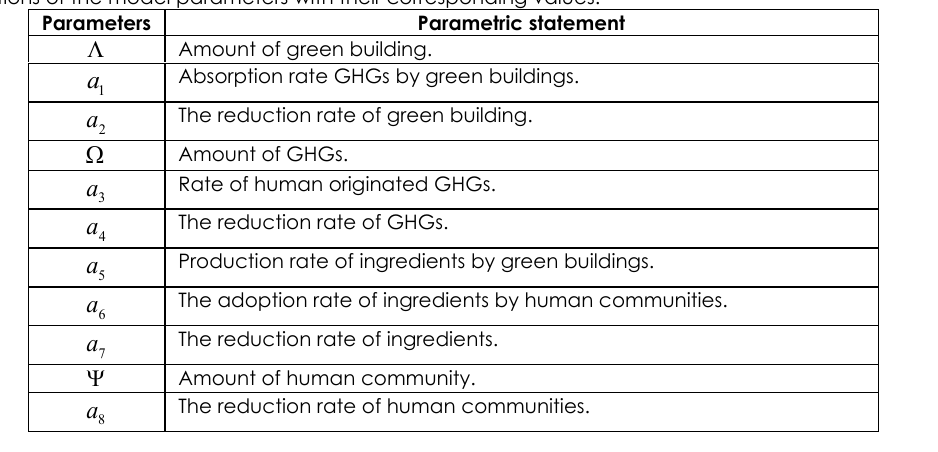
Table 1. Descriptions of the model parameters with their corresponding values. Parameters Parametric statement Amount of green